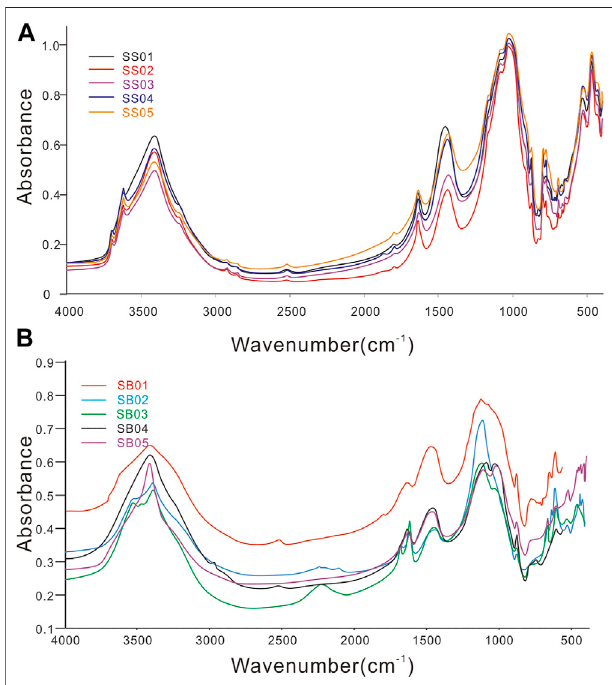
FIGURE 3 | FTIR spectra of different lithologic samples: (A) Silty sand; (B) Salt-bearing strata.